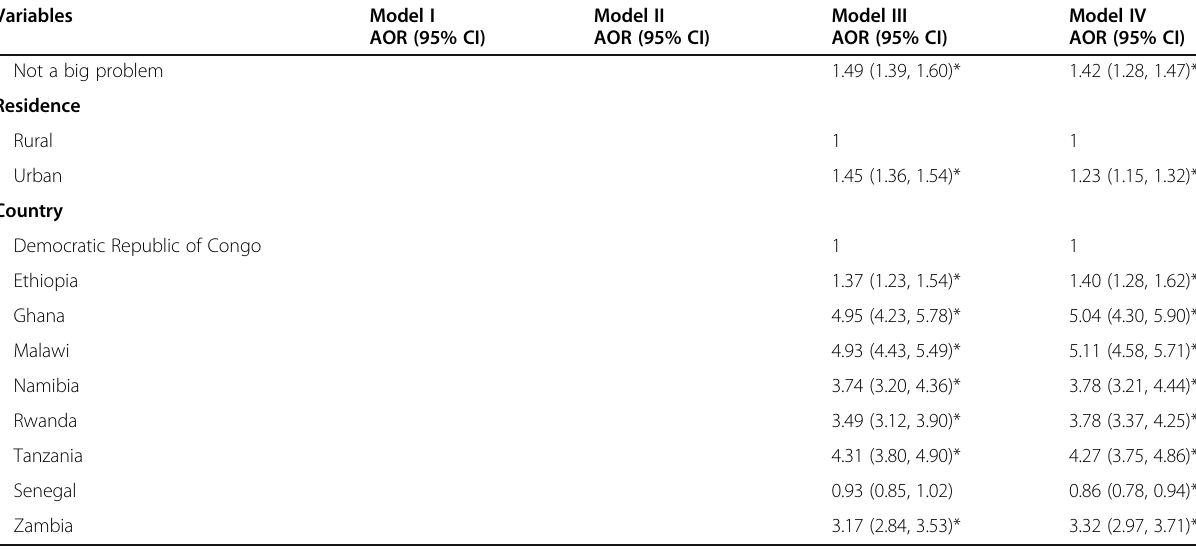
Table 3 Multivariable multilevel logistic regression analysis of both individual and community-level factors associated with childhood immunization in sub-Saharan African countries (Continued) Variables